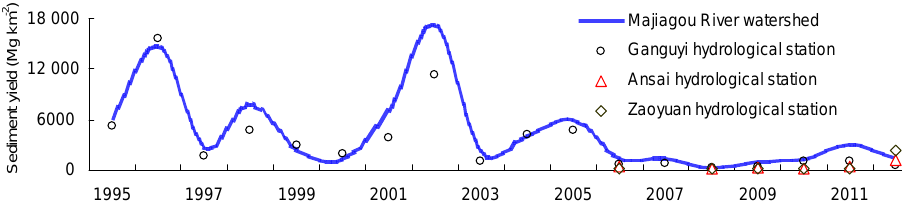
Figure 6. Validation of the sediment yield modulus among Ganguyi, Ansai, and Zaoyuan hydrological stations and the Majiagou River watershed based on the modified